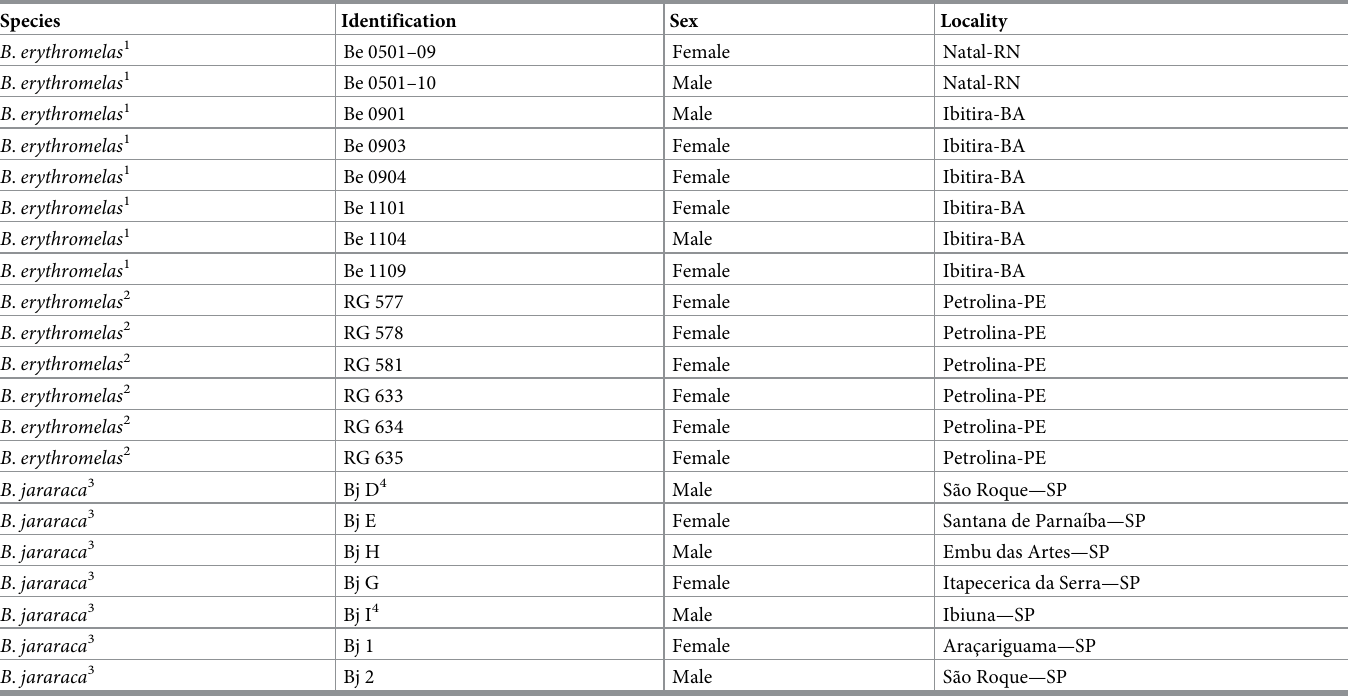
Table 5. Snakes whose venoms have been tested for coagulant